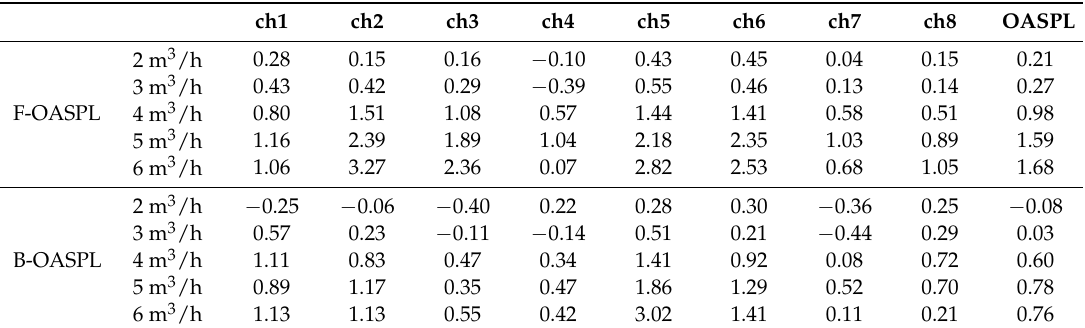
Table 3. OASPL reduction of circumferential channels